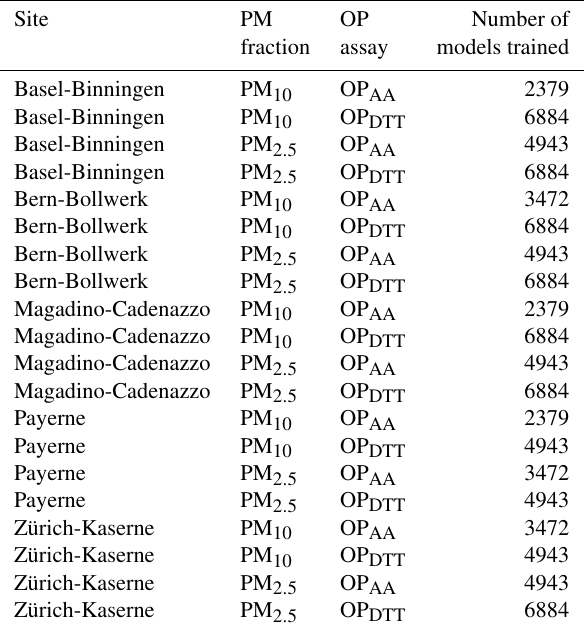
Table A2. The number of multiple linear regression (MLR) mod- els trained for each site, PM size fraction, and OP assay. The total number of models was